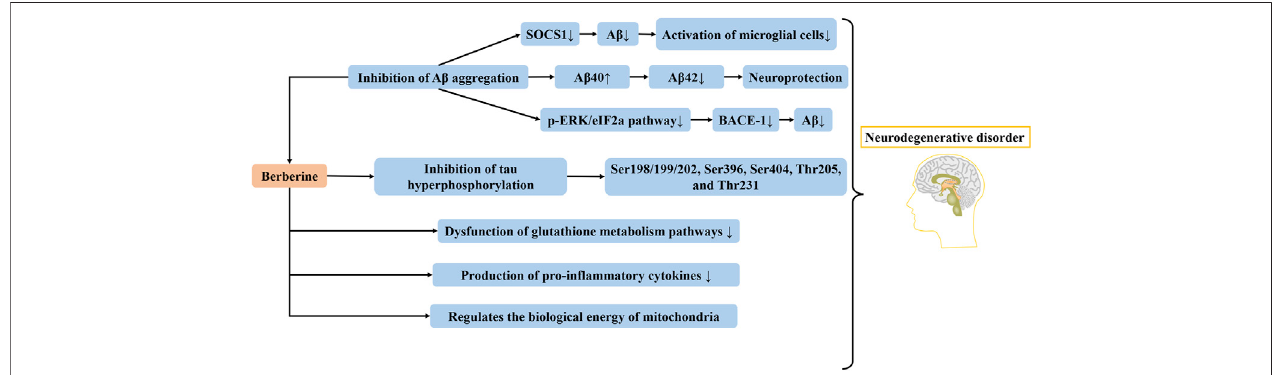
FIGURE 2 | The therapeutic effect of berberine on Alzheimer ’ s disease. Berberine inhibits A β aggregation, tau hyperphosphorylation and pro-in fl ammatory cytokines production, in addition to regulating glutathione metabolism pathways and mitochondrial bioenergetics. SOCS1, suppressor of cytokine signaling 1; A β , amyloid β ; BACE1, beta-secretase 1; p-ERK, phosphorylated extracellular signal-regulated